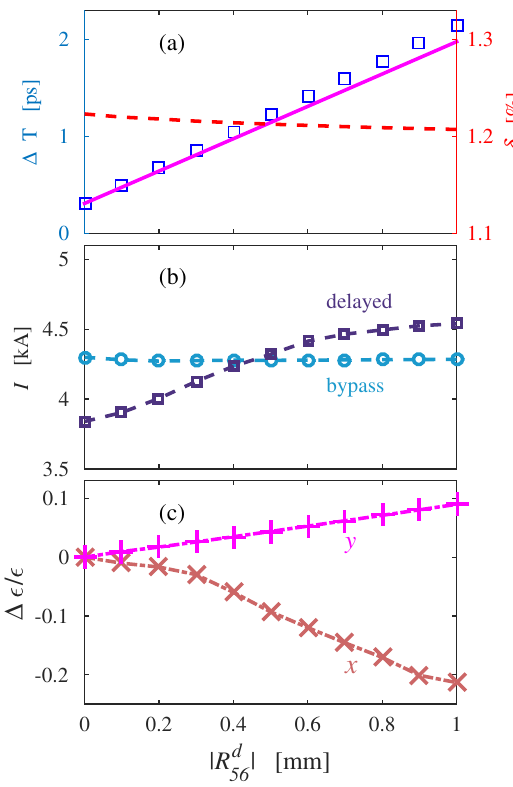
FIG. 8. Parameters of the twin bunches versus the j R d 56 j of the delay chicane. (a): final time delay (blue square) and energy separation (red dashed line); the solid line is the time delay calculated by 1st-order analysis; (b): peak current of the delayed bunch (square) and the bypass bunch(circle); (c): the projected emittance changes of the twin bunches in x (cross) and y (plus)